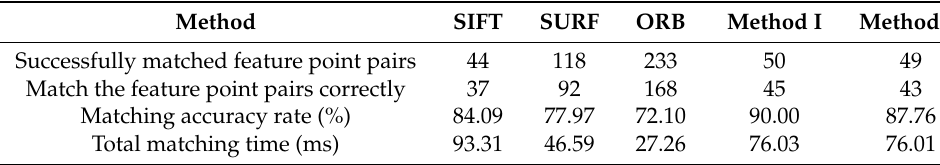
Table 1. Feature matching results of various methods.